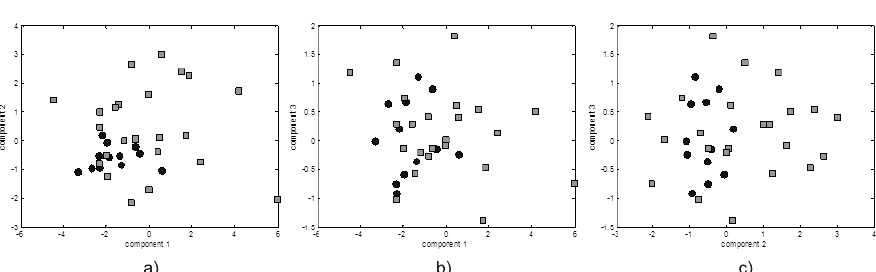
Figure 10. Observations from treatment group divided into groups of steroid treatment on principal component axes